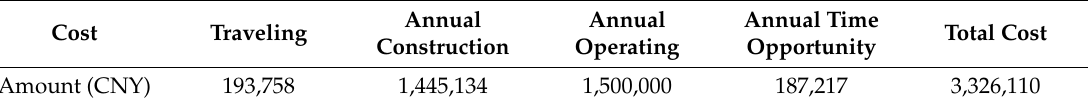
Table 4. The planning cost of the optimal solution.